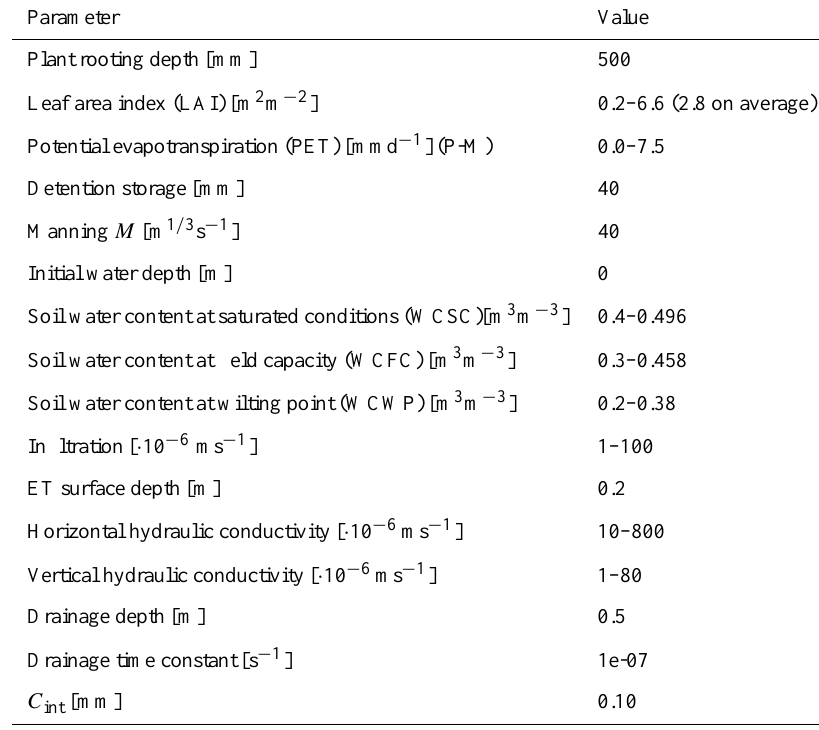
Table 2. Initial values of important parameters of MIKE SHE simulation model a